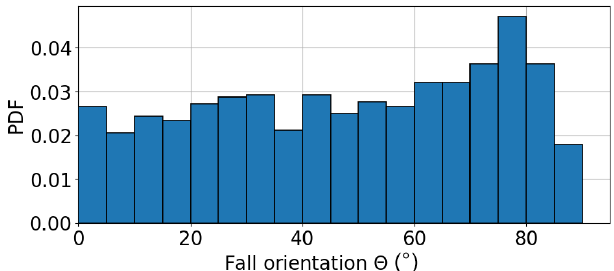
Figure 10. Histogram of the falling columnar crystals’ orientation (cid:50) , with 90 ◦ corresponding to a fall with the major axis normal to the falling direction. N =